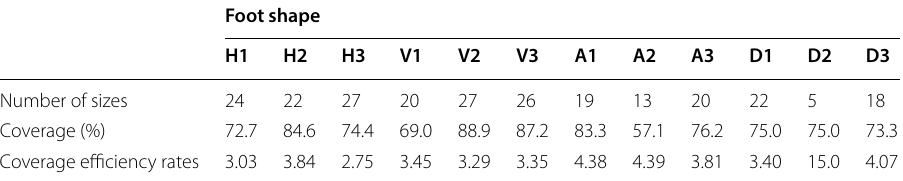
Table 7 Coverage according to the elderly men’s foot shape